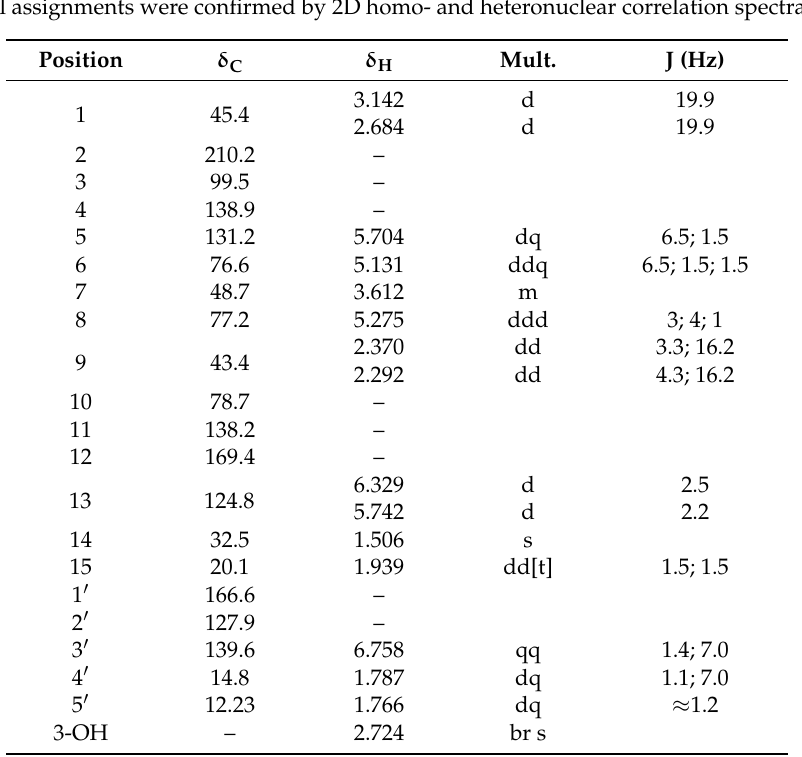
Figure 1. Structures of the isolated STLs (sesquiterpene lactones). Table 1. 13 C and 1 H NMR data of the new STL (sesquiterpene lactones) 4 (150 and 600 MHz, respectively, CDCl 3 ); all assignments were confirmed by 2D homo- and heteronuclear correlation